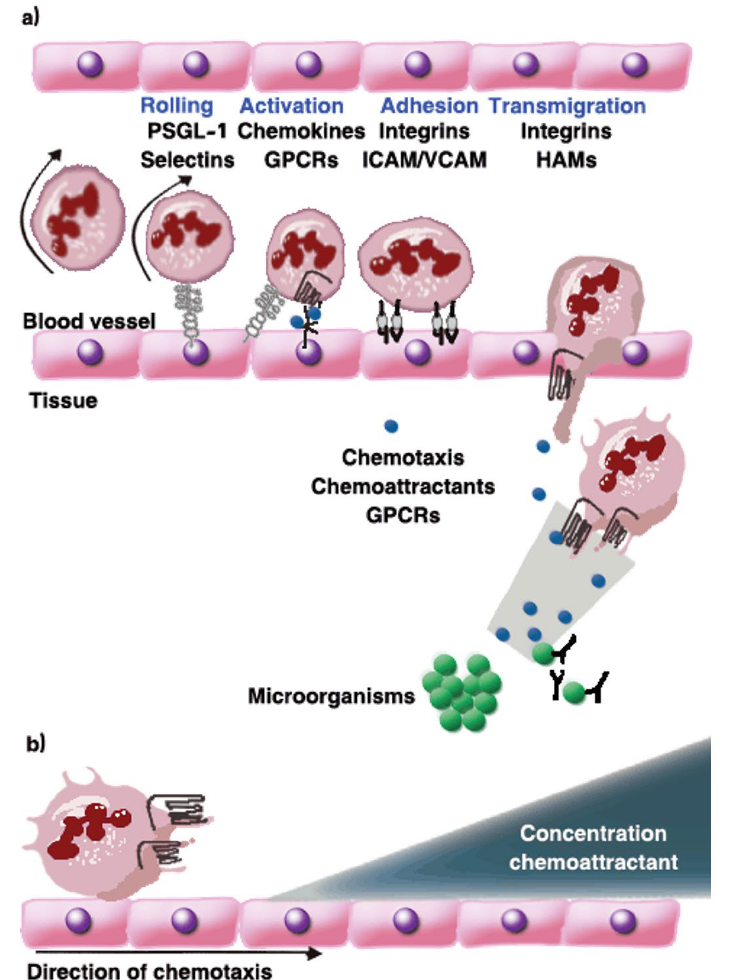
Fig. 3. Phagocyte extravasation: (a) for phagocytes to reach infection sites, they need to extravasate from the blood vessels into the tissue. The successful recruitment of circulating immune cells depends on the productive interaction of leukocytes with the endothelial cells lining the vessel wall and it is a multistep process. Phagocytes tether and roll on activated endothelium through transient interactions of PSGL-1 and selectins. Following stimulation of the cells by endothelium bound chemokines, integrins are activated that mediate the firm cellular adhesion to intercellular adhesion molecule-1 (ICAM-1) and vascular adhesion molecule-1 (VCAM-1) presented by the vessel wall. The phagocytes then transmigrate through the endothelium into the underlying tissue .The cells are directed to the site of infection through the sensing of chemoattractant gradients by GPCRs. Here, chemokines and bacteria and complement derived products are important. The pathogen is cleared by phagocytosis upon recognition of the bacterium opsonized by antibodies and/or complement components. (b) At the infection site, infected cells and the surrounding tissues release chemoattractants. These secreted chemoattractants form a concentration gradient and attract leukocytes, which move through the gradient towards the higher concentrations, a process called chemotaxis. Leukocytes move through the gradient toward the higher concentrations, a process called chemotaxis [25, 26, 17]